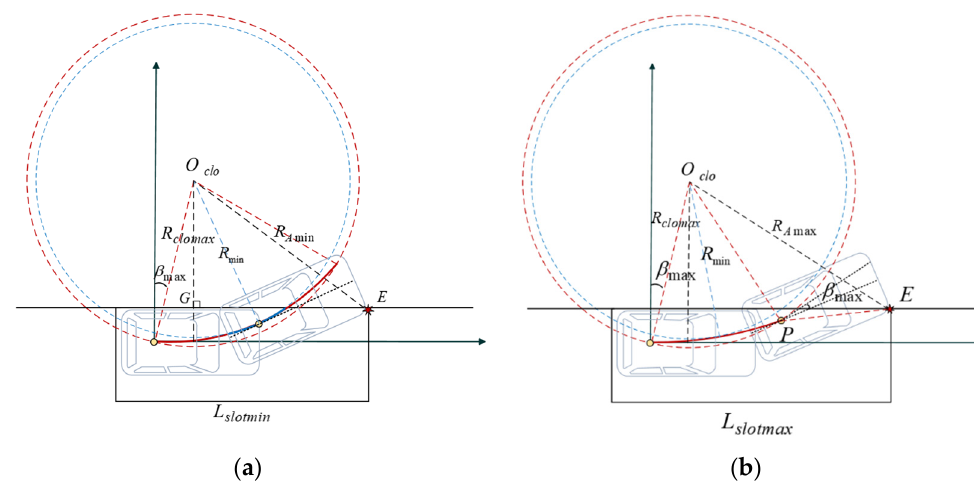
Figure 12. Minimum parking space in two cases: ( a ) lower bound; ( b ) upper bound.